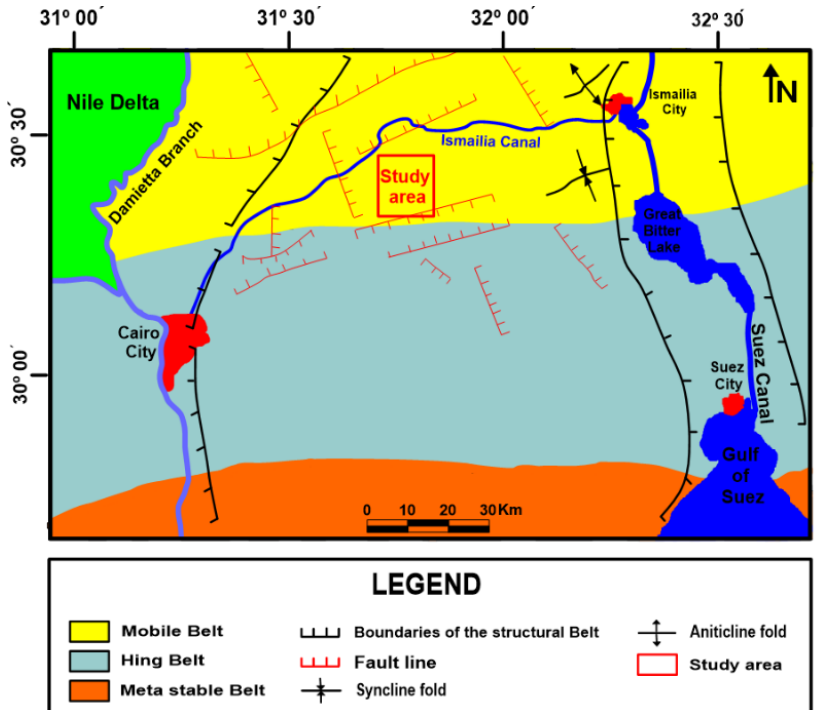
Figure 2. Structural zones of the eastern Nile Delta and area of study (modified after El-Fayoumi, 1968